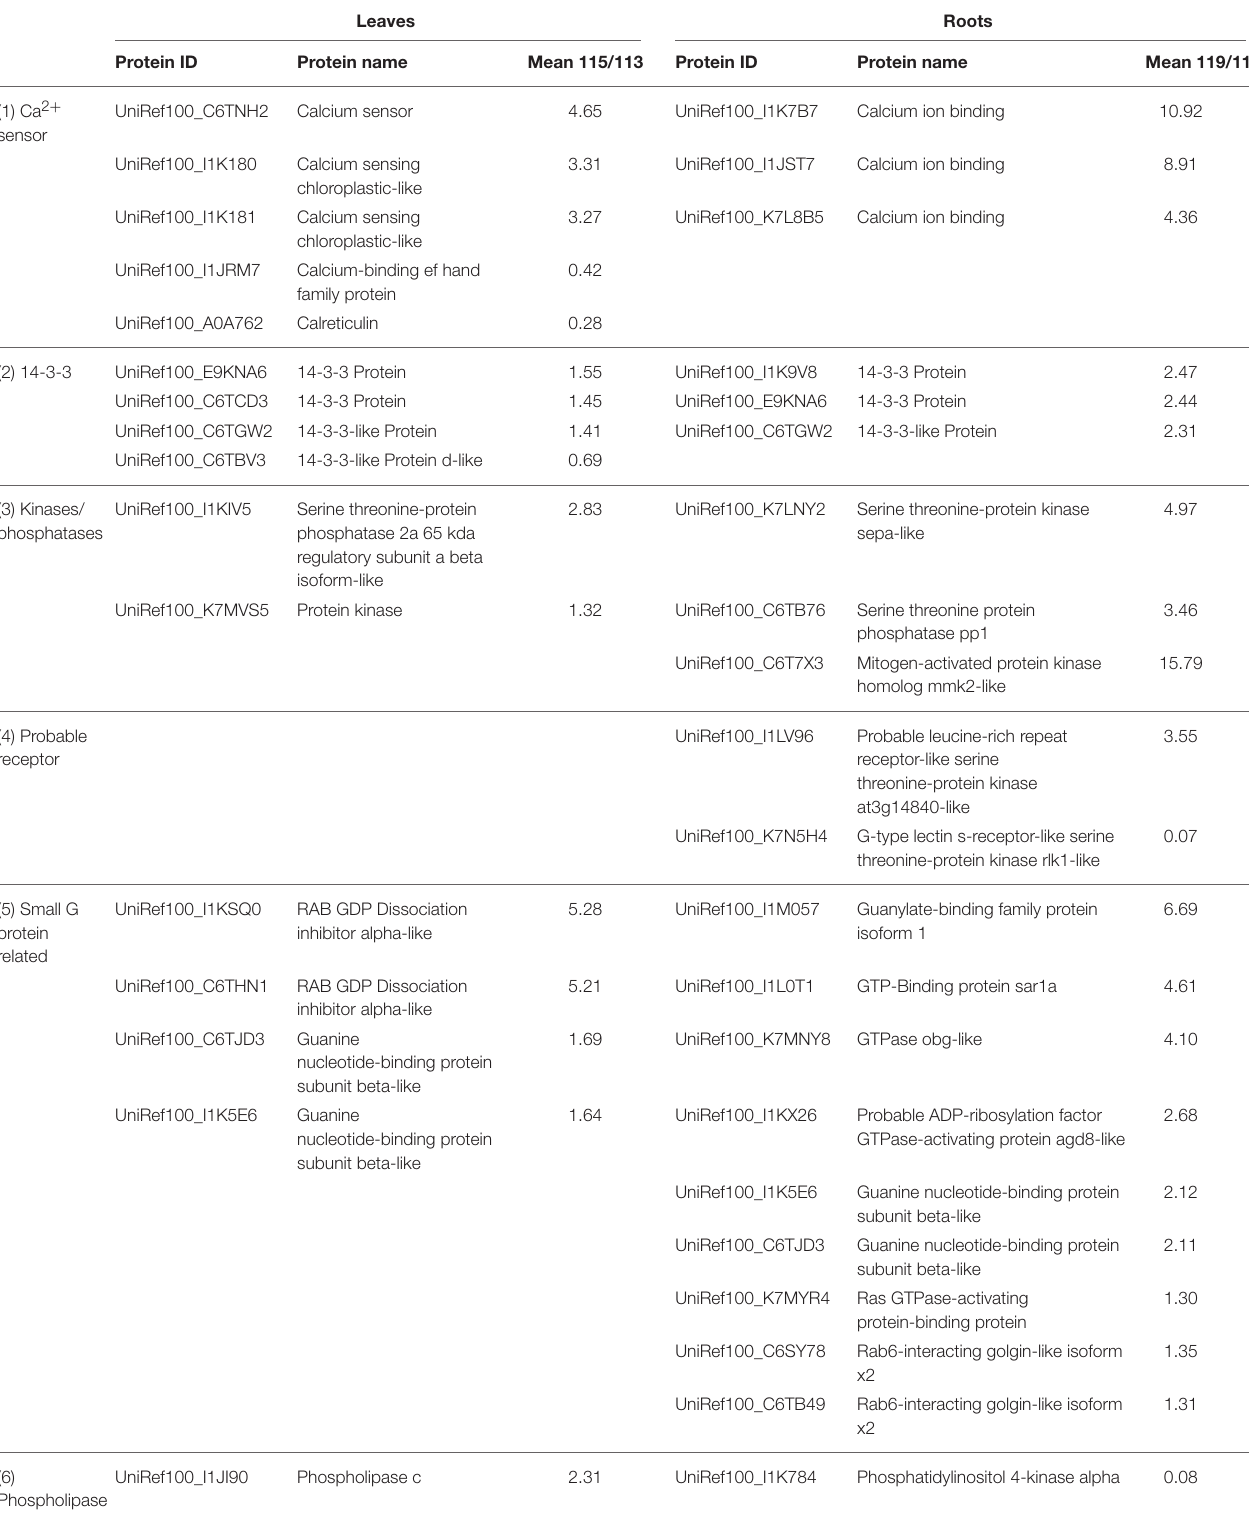
TABLE 1 | Signaling-related proteins differentially expressed under salt stress in soybean leaves and roots. Leaves